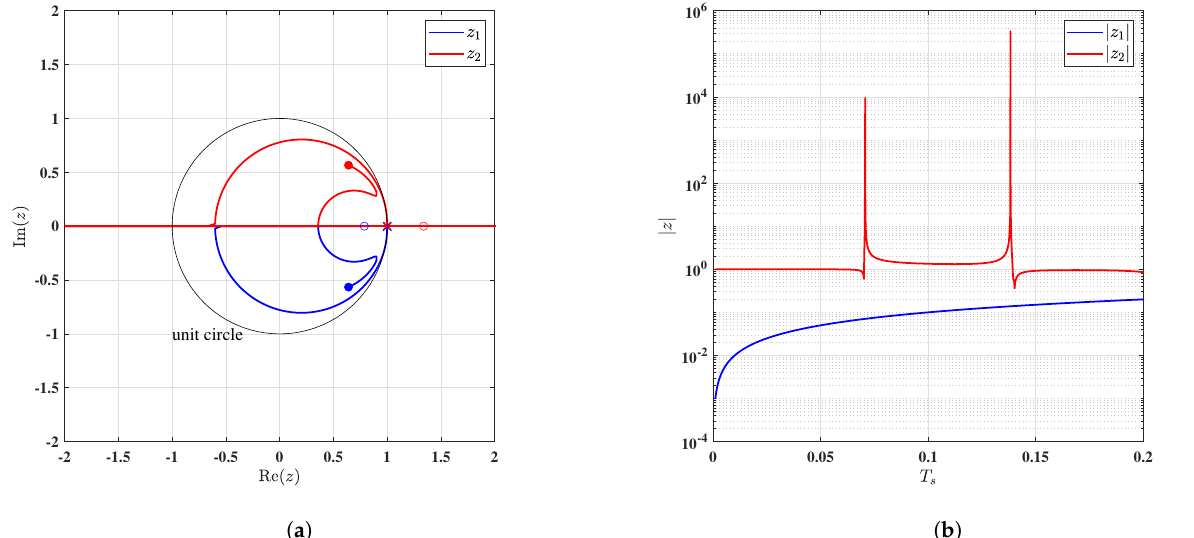
Figure 5. ( a ) Locus of discrete-time zeros and ( b ) the magnitude of them with respect to the sampling time T s